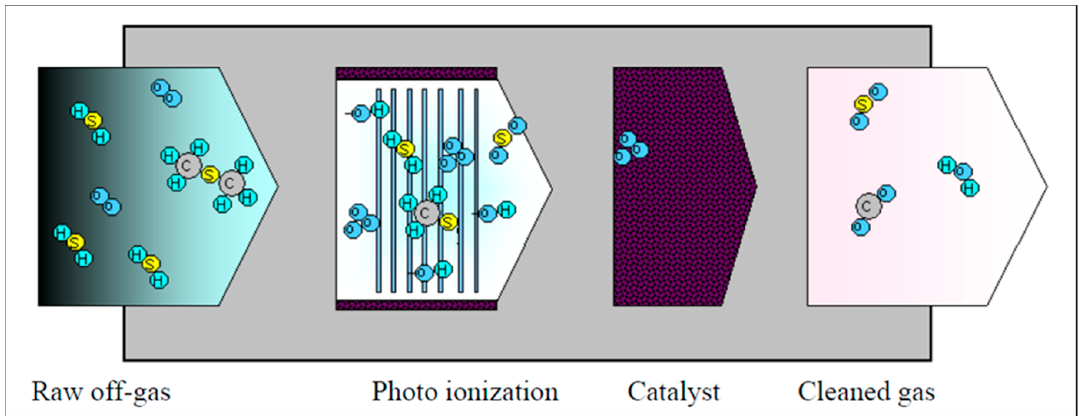
Figure 4. Scheme of photocatalytic oxidation [23].